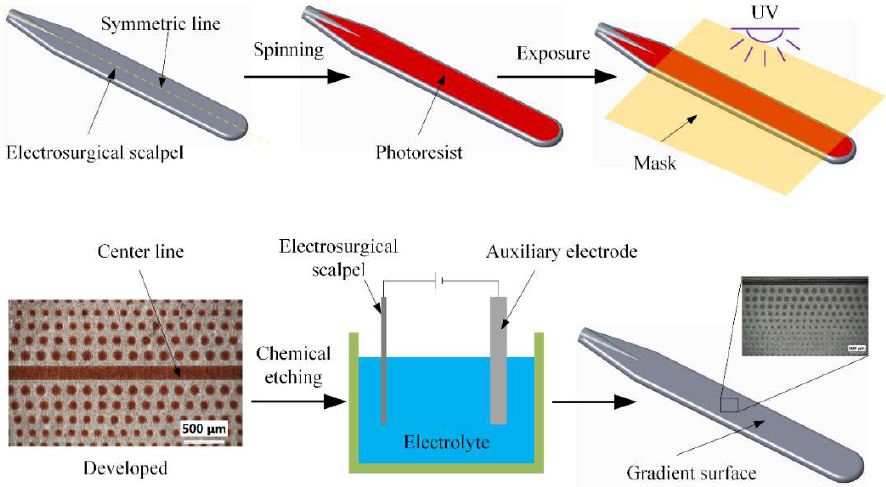
Figure 2. Schematic of non-uniformly distributed cylindrical micro pillars fabrication.